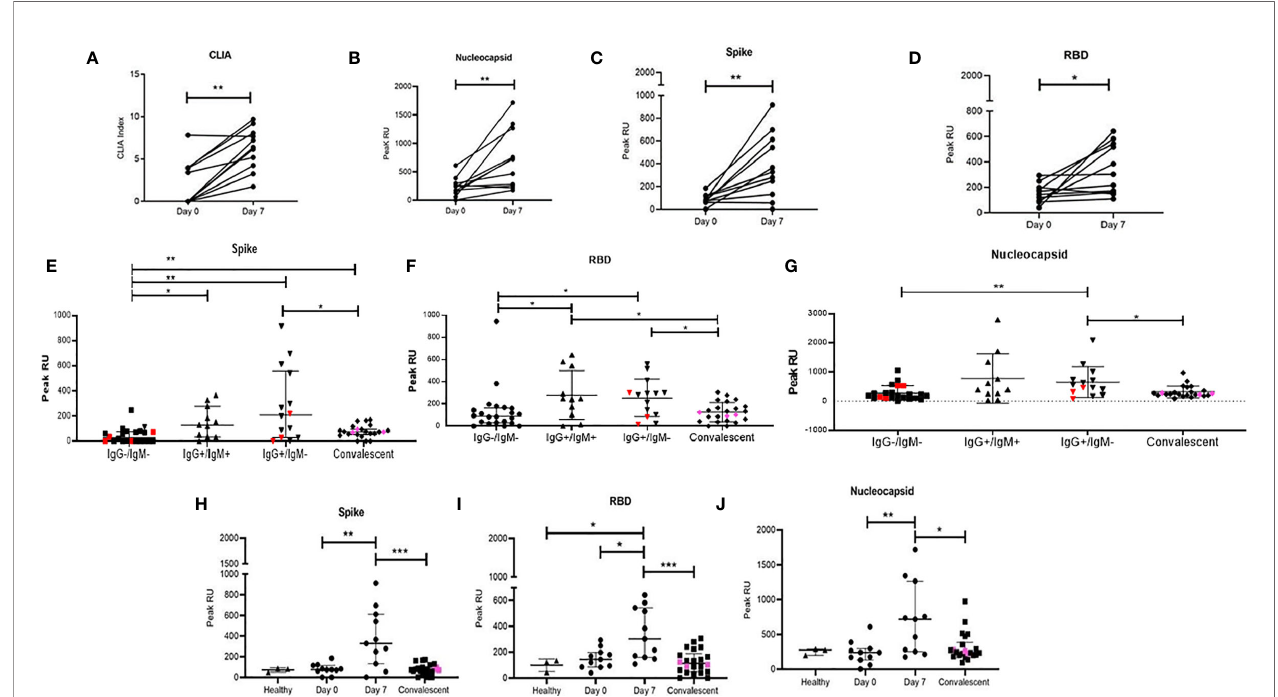
FIGURE 4 | Distribution of peak RU across various groups of study participants. Variation in levels of (A) CLIA (NC speci fi c) index. Peak RU for (B) Nucleocapsid, (C) Spike, and (D) RBD among study participants followed up in this study. Comparison of peak RU for (E) Spike (F) RBD and (G) Nucleocapsid between healthy (n = 3), IgG − /IgM − (n = 22), IgG+/IgM+ (n = 11), IgG+/IgM − (n=14), and convalescent (n = 22) groups. Variation in peak RU for (H) Spike, (I) RBD, and (J) Nucleocapsid, compared at day 0 (n = 11), day 7 (n = 11), and in convalescent (n = 22) group. Red colored symbols represent asymptomatic individuals. Pink colored symbols indicate IgG − /IgM − individuals in convalescent group. Statistical signi fi cance was calculated by Mann – Whitney U-test; *p < 0.05; **p < 0.01; and ***p <